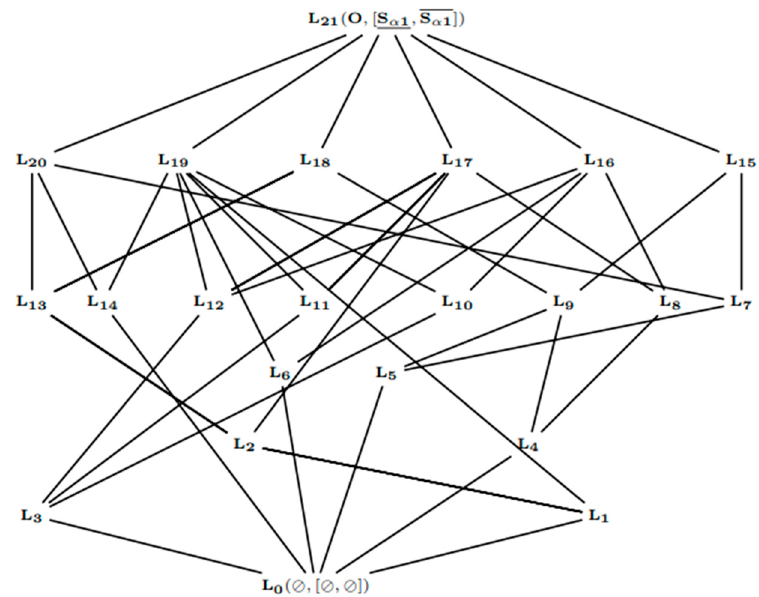
Figure 7. From Table 𝑆 (cid:3080)(cid:2869) . Table 7. 𝑆 (cid:2870)